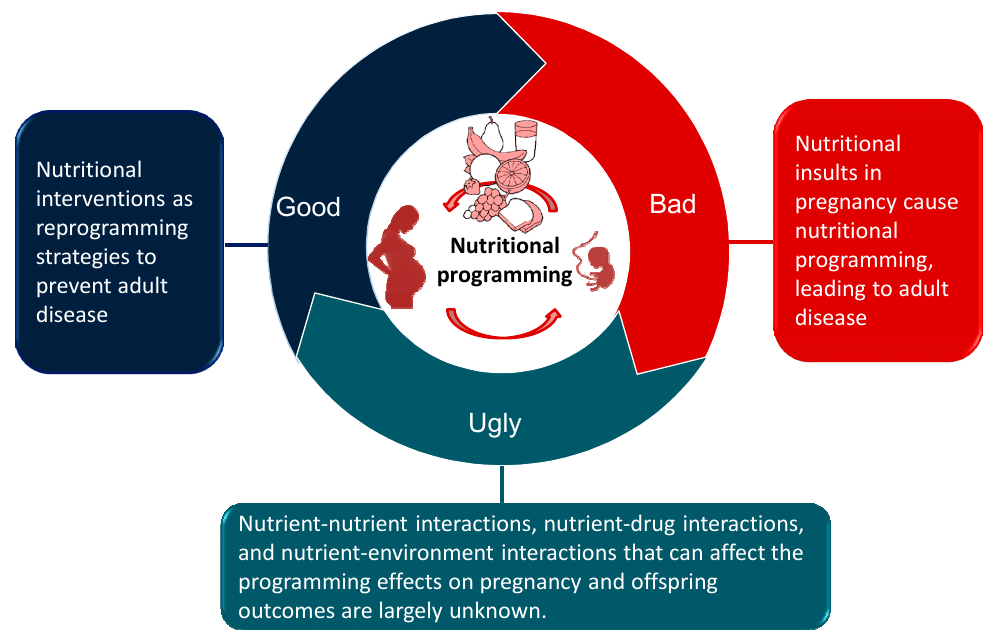
Figure 1. Schematic illustration of the good, the bad, and the ugly sides of nutritional programming involved in developmental programming of health and disease.